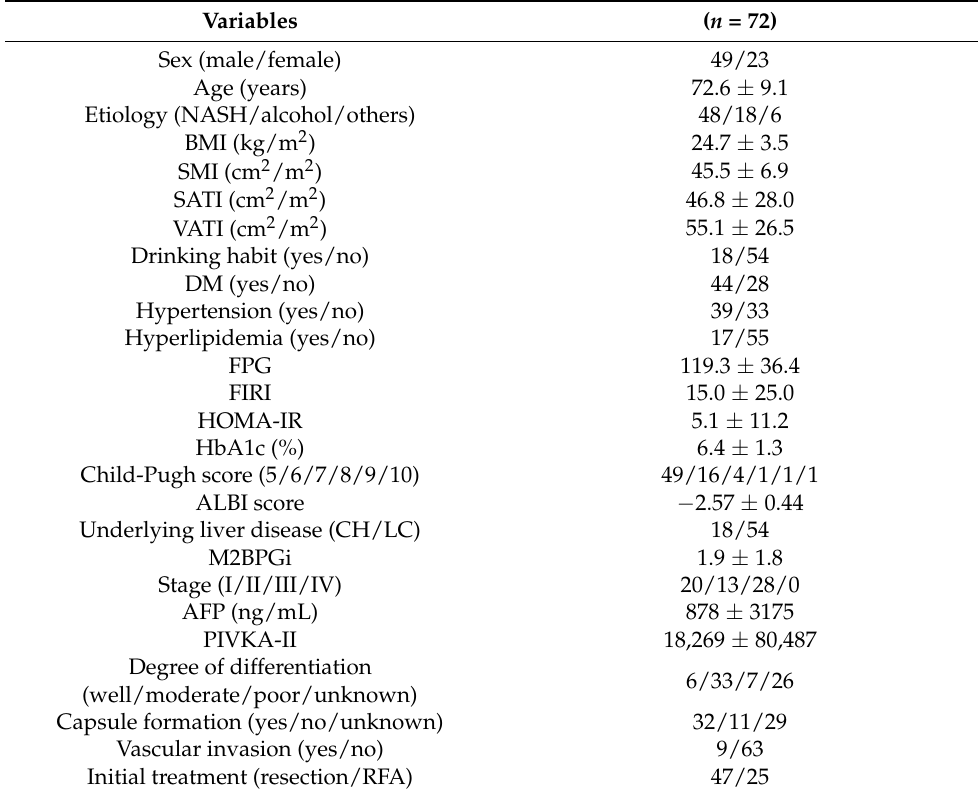
Table 1. Baseline demographic and clinical characteristics of the enrolled patients on primary non-B non-C